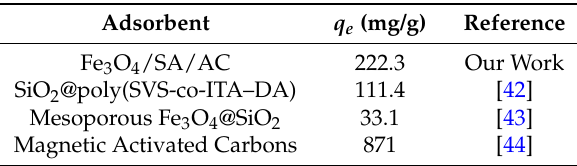
Table 4. Adsorbent performance of MB in literature.